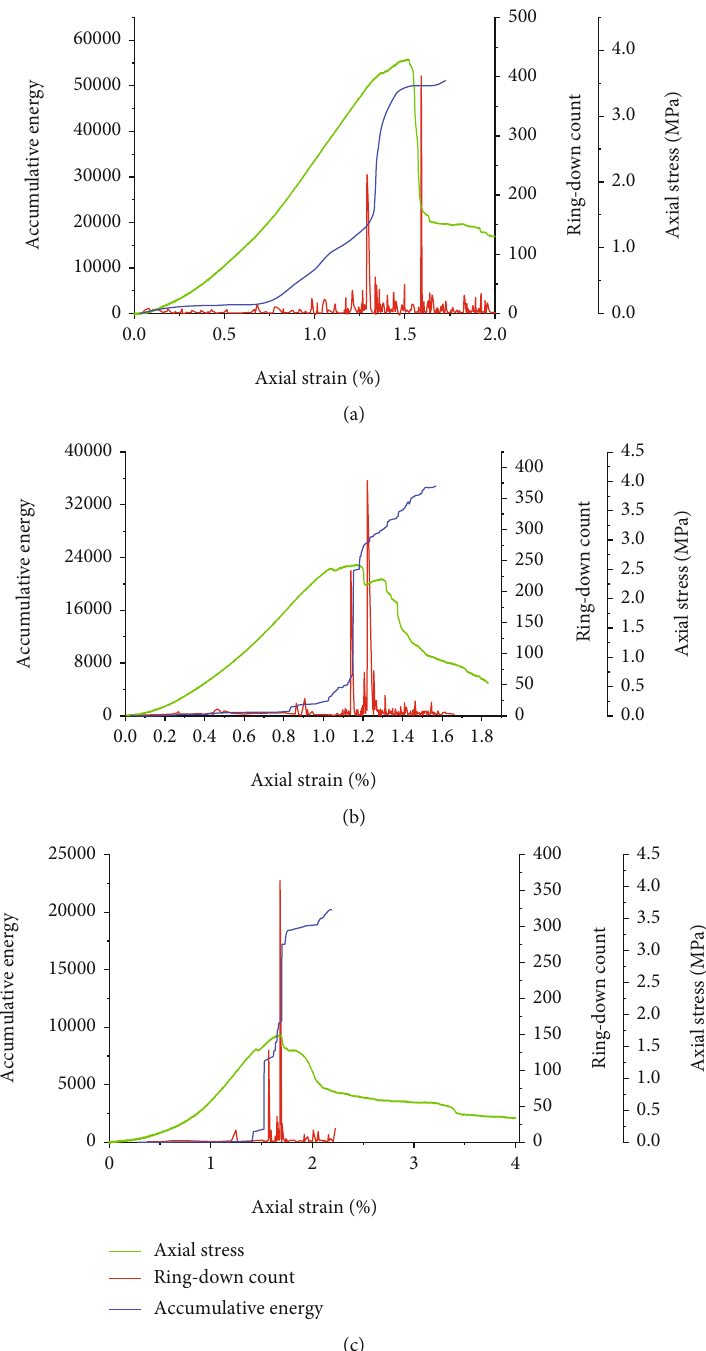
Figure 8: Stress-strain-accumulative energy-ring-down count curves under di ff erent moisture contents ((a) 17%; (b) 21%; (c)